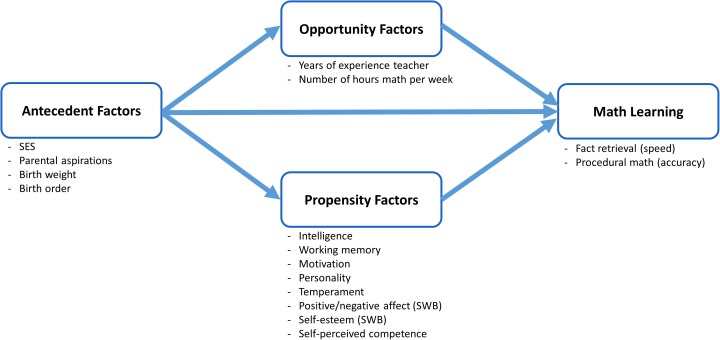
Operationalization of the O-P Model in this study. Adapted from Byrnes and Miller (2007, p. 602).